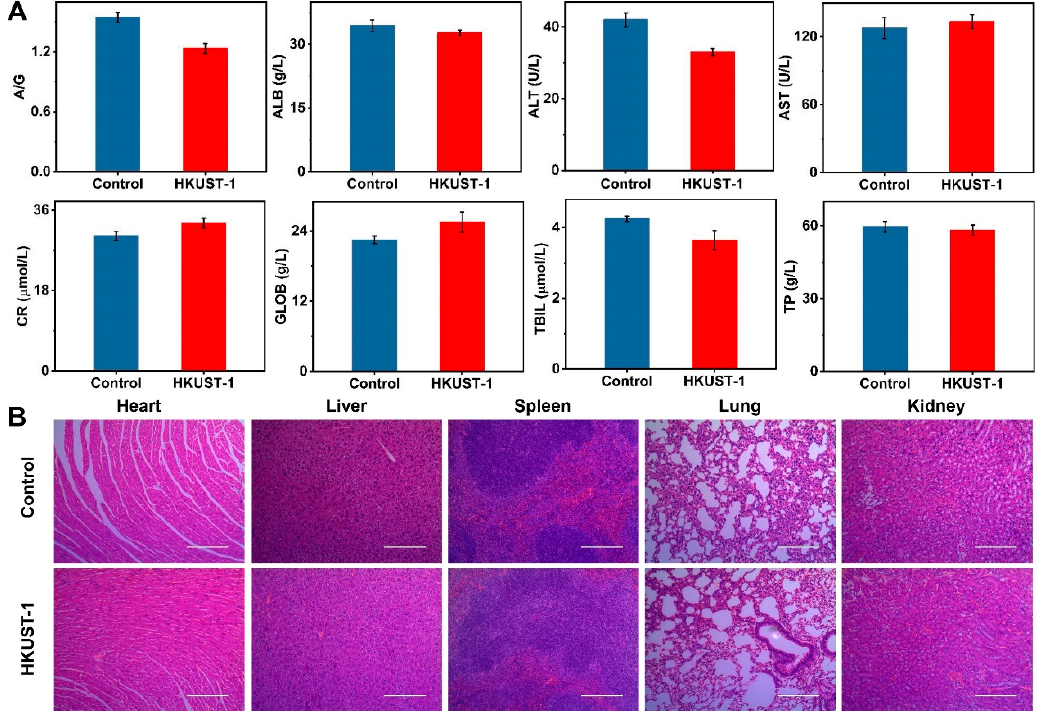
Figure 5. ( A ) Levels of different blood biochemical indexes (A/G, ALB, ALT, AST, CR, GLOB, TBIL, and TP) after intravenous injection with PBS solution or HKUST-1. ( B ) H&E staining of major organs after 7 days of treatment obtained from mice. Scale bar = 200 μ m.